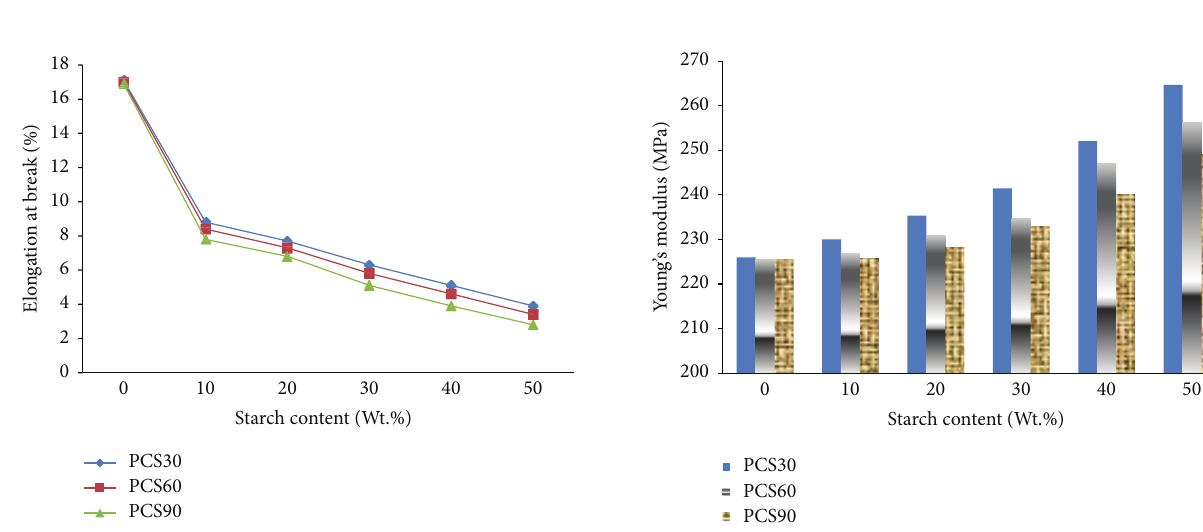
Figure4:ElongationatbreakofPP/PCCSblendsafterthesoilburial test.